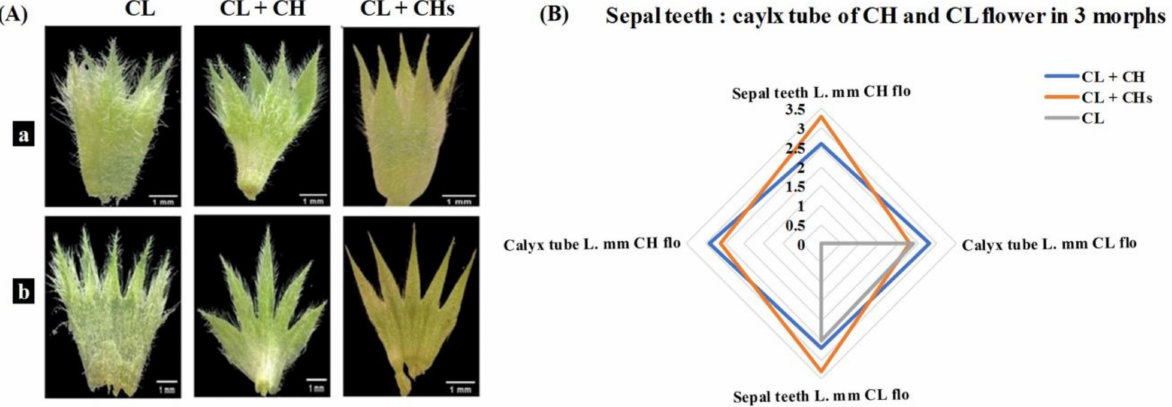
Figure 3. Calyx in the three morphs ( A ) Calyx feature where a: whole sepals and b: dissected sepals ( B ) Statistical model showing the sepal teeth: calyx tube in the three